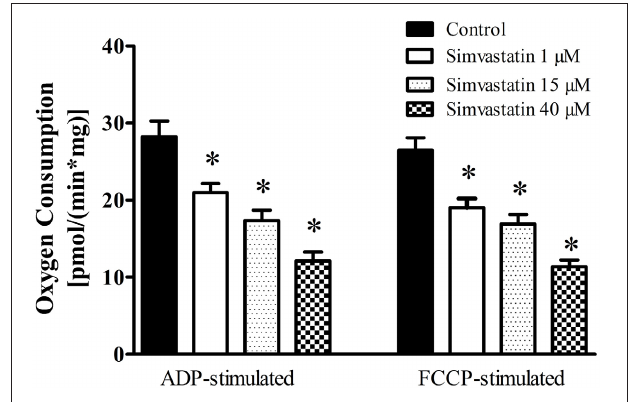
FIGURE 1 | Inhibition by simvastatin of ADP- or FCCP-stimulated oxygen consumption supported by complex I substrates in skeletal muscle. Skeletal muscle samples were incubated in MiR05 medium in the presence of 1, 15, and 40 μ M simvastatin, or DMSO for 1h. ADP (400 μ M) or 1 μ g/mL oligomycin plus 0.2 μ M FCCP were added where indicated. Respiration was supported by 10mM glutamate plus 5mM malate. ∗ p < 0 . 05 vs. control by one-way analysis of variance. N = at least 6 independent